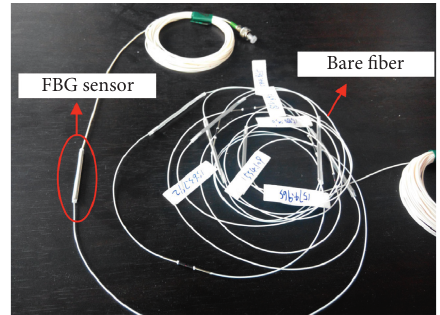
Figure 2: FBG sensor